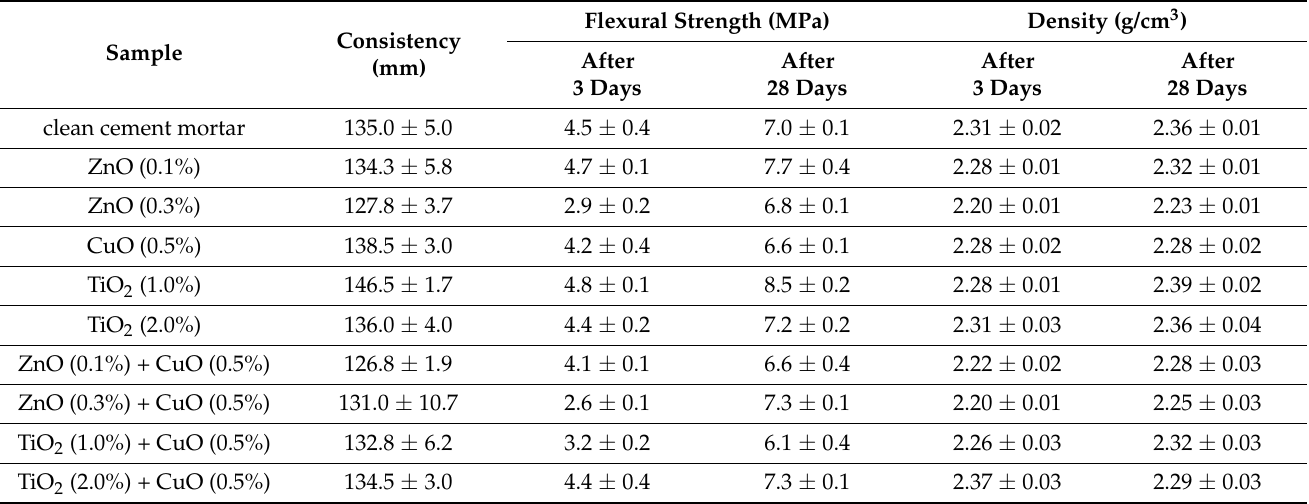
Table 3. Consistency, flexural strength and density of cement mortars containing oxides in vary- ing